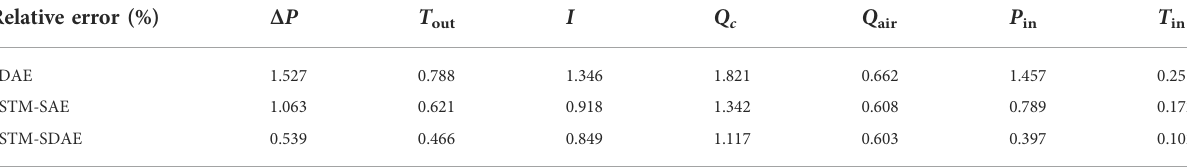
TABLE 4 Relative errors comparison of the three models. Relative error (%)